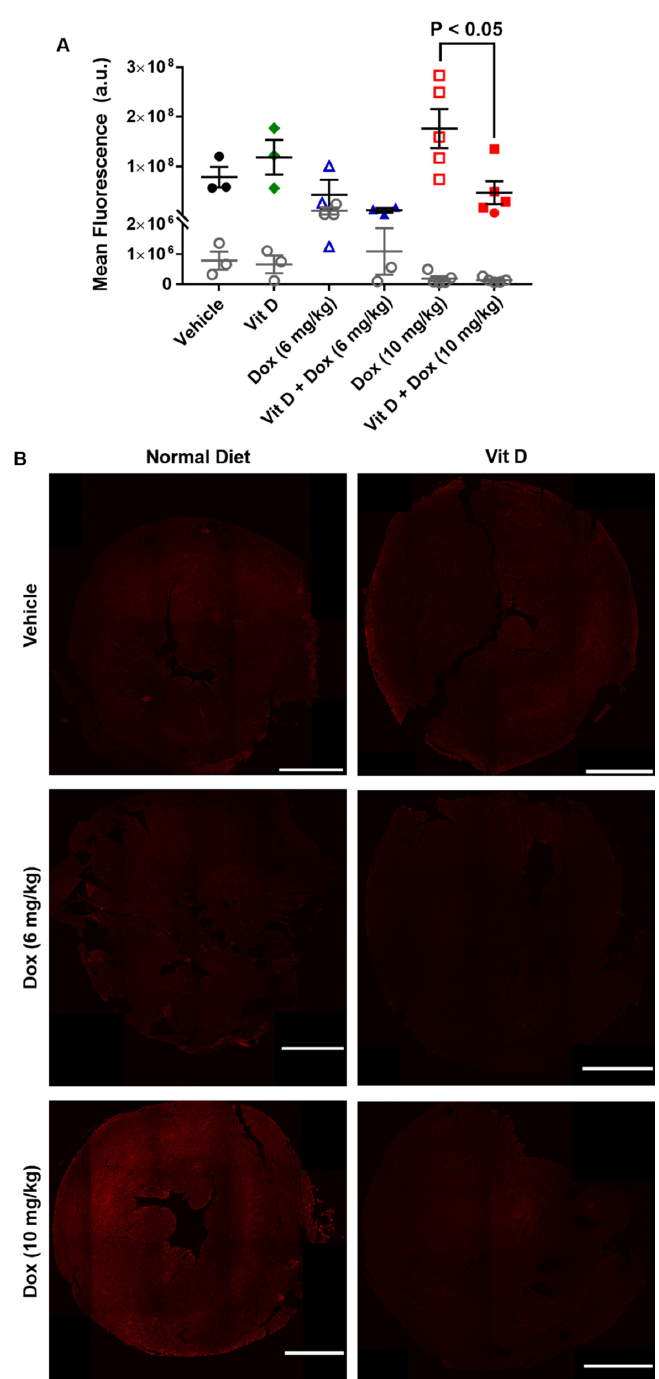
Figure 5. C-MYC expression in cardiac tissue of mice treated with vitamin D and doxorubicin. ( A ) Fluorescence intensity of C-MYC. Comparison of Dox (10 mg/kg), (1.8 ± 0.4) × 10 8 AU vs. vehicle, (0.8 ± 0.2) × 10 8 AU; p = 0.27. Comparison of Dox (10 mg/kg), (1.8 ± 0.4) × 10 8 AU vs. Vit D + Dox (10 mg/kg) (0.5 ± 0.2) × 10 8 AU; p < 0.05 Comparison of Vit D, (1.2 ± 0.4) × 10 8 AU; Dox (6 mg/kg), (0.4 ± 0.3) × 10 8 AU; or Vit D + Dox (6 mg/kg), (0.1 ± 0.04) × 10 8 AU vs. vehicle were non-significant. Immunoglobulin G control, open gray circles. ( B ) Representative images of cardiac tissue (thickness, 5 µ m) showed the greatest C-MYC (shown in red) fluorescence intensity for mice treated with Dox (10 mg/kg). Dox (10 mg/kg) and Vit D + Dox (10 mg/kg), five mice per group; all other groups, three mice per group (scale bar, 1000 µ